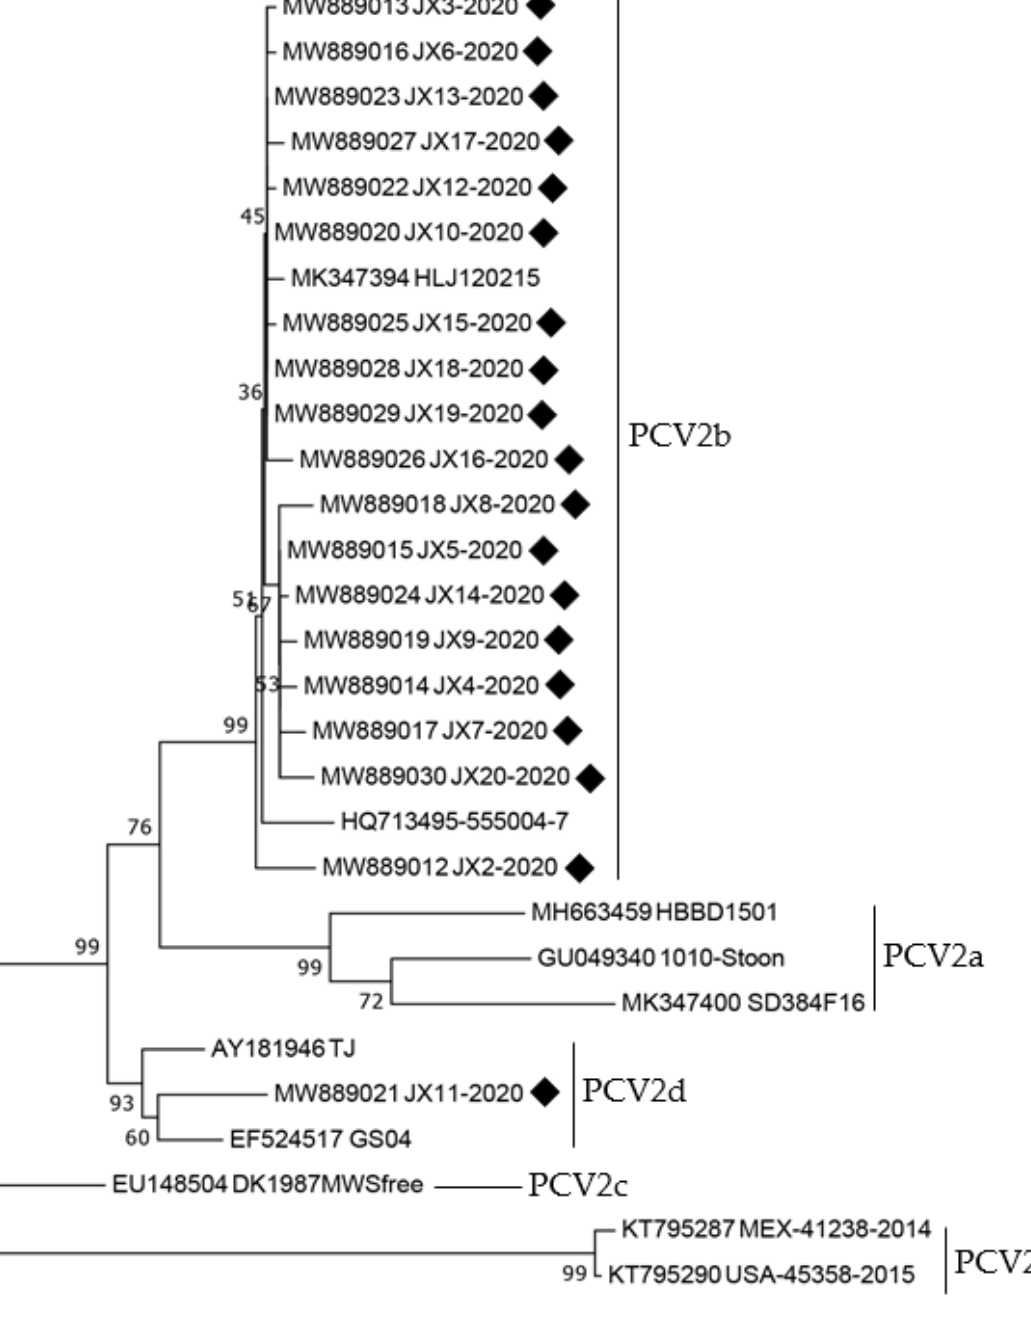
Figure 4. Phylogenetic tree based on the ORF2 amino acids of 19 PCV2 sequences amplified in this study and 10 PCV2 reference sequences). The sequences obtained in this study have been marked with a black square. The phylogenetic tree was performed using the p-distance-based neighbor joining (NJ) method with bootstrap analysis of 1000 replicates in MEGA 7.0 software.